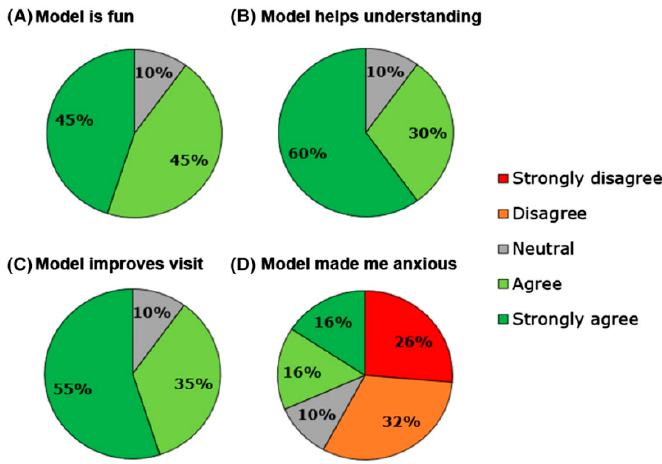
Figure 7. Participants’ response to different statements on the usefulness of 3D printed models. Reprinted with permission under the open access from Biglino et al. [36].